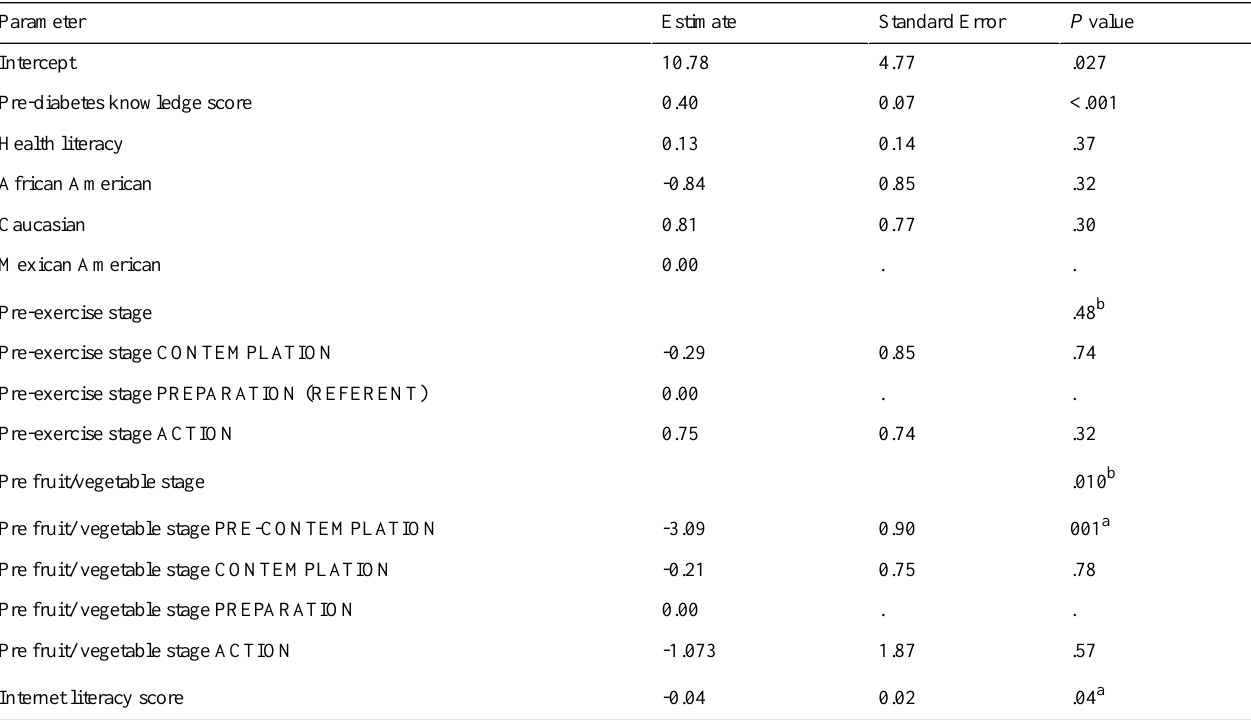
Table 7. Diabetes knowledge post exposure to website controlling for health literacy, ethnicity, transtheoretical model stage for exercise and fruit and vegetable consumption, and Internet